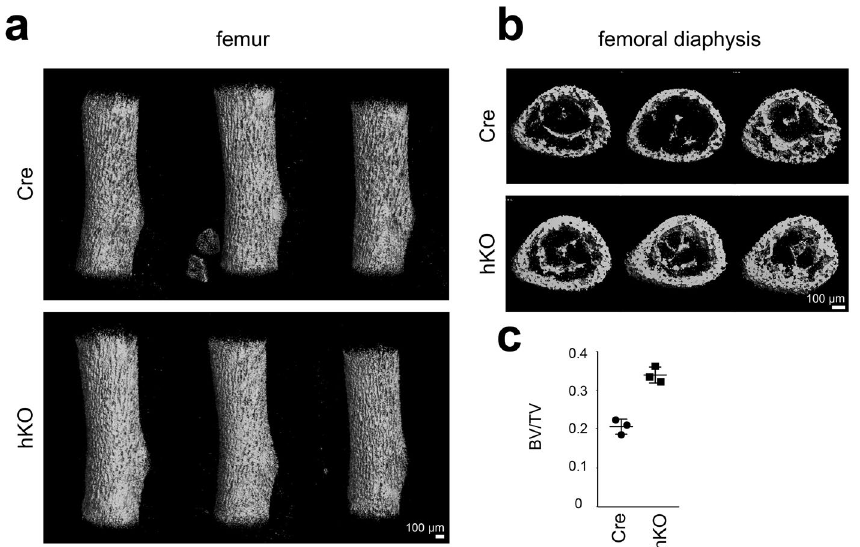
Figure 1. Analysis of femora of Mirc24 cluster-deficient mice. μCT analysis of femora from newborn male Col2a1-Cre (Cre) and Col2a1-Cre- Mirc24 tm1M/Y (hKO) mice. Three animals per genotype are shown. ( a ) Three dimensional reconstructions of the femora. ( b ) Cross-sections of the femoral diaphysis. ( c ) Relative bone volume (BV/TV). Individual and mean values and standard deviations are shown (graph). The figure was created with Adobe Illustrator CS6 (Version 16.0.3, https:// adobe. com/ produ cts/ illus